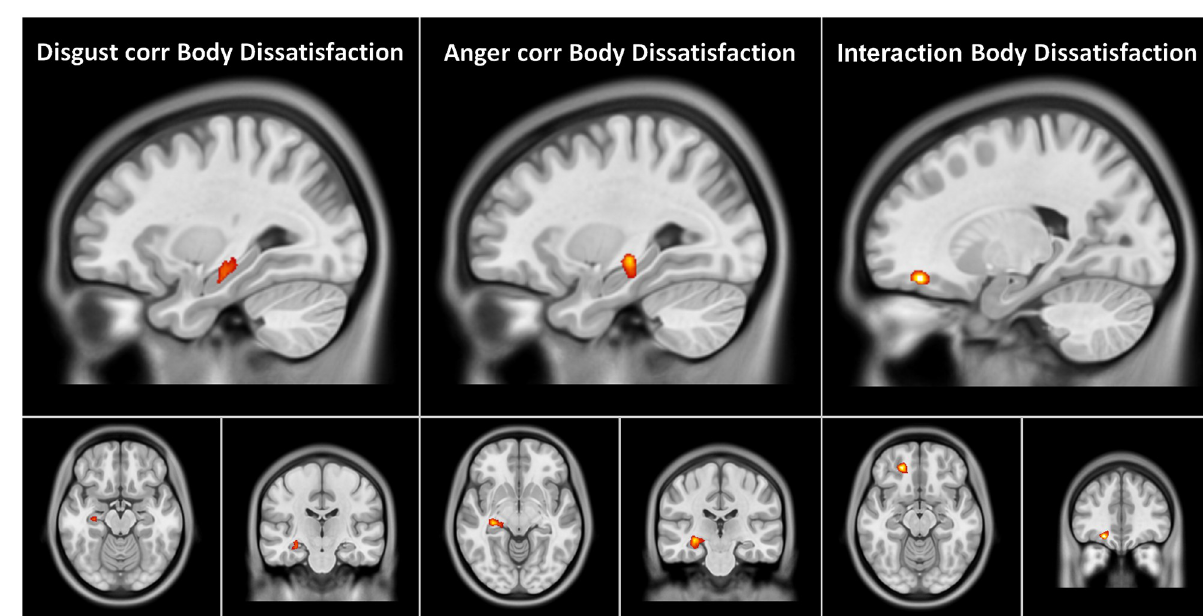
Fig 7. fMRI relationship with clinical data. Correlation between the activation of a cluster in the left hippocampus during disgust and anger stimuli compared to baseline (neutral condition) and the Eating Disorder 2 subscore for Body Dissatisfaction. No interaction emerged except for EDI-2 Body Dissatisfaction score and anger in which a significant interaction was observed in an orbitofrontal cluster only for controls. Clusters depicted on orthogonal projection of an ICBM-152 brain template in neurological convention.